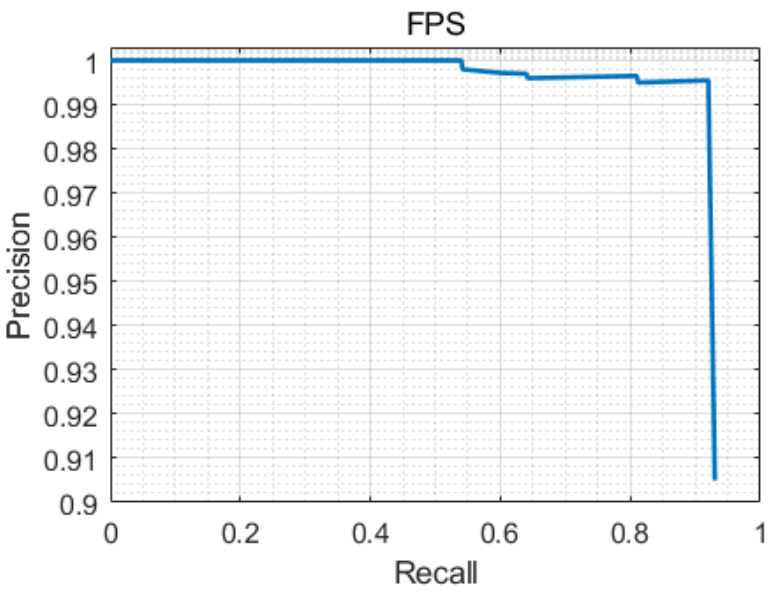
Figure 11. The precision and recall curve of target detection of this paper algorithm. In terms of target detection speed, when the FPS of the algorithm is greater than 24, it is generally considered that it has good real-time performance. Figure 12 shows the FPS during the process of target detection of this paper algorithm. The average FPS reaches 34.5, indicating that the algorithm has excellent real-time performance. Table 1 is the comparison of accuracy and speed performance of different target detection algorithms.